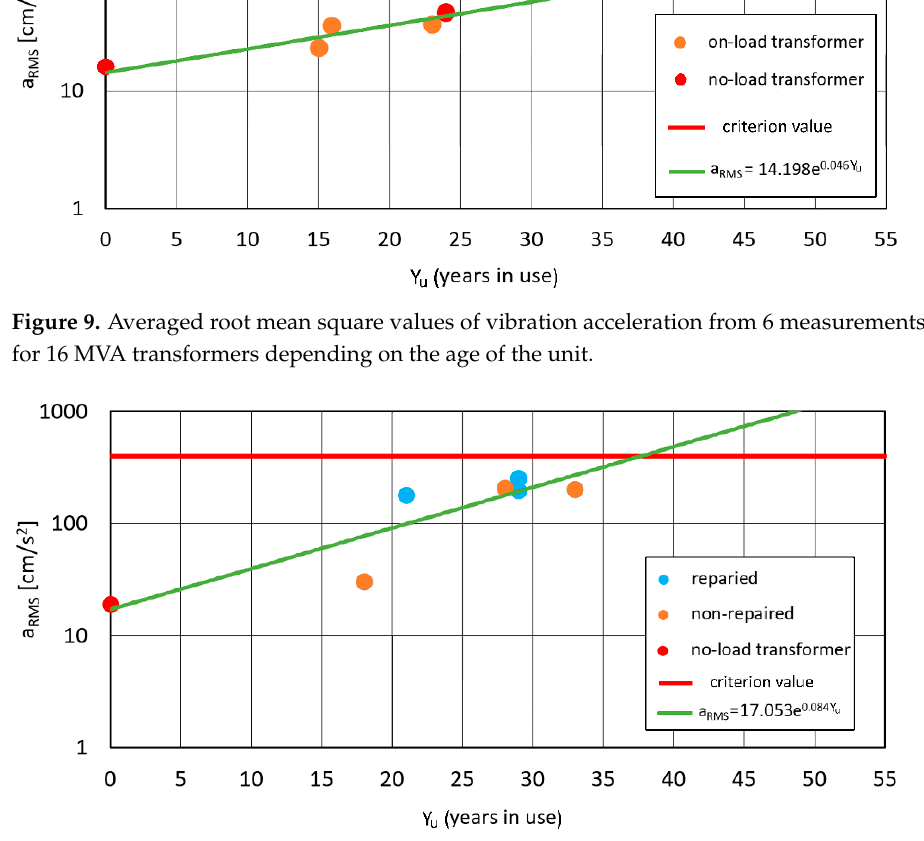
Figure 10. Averaged root mean square values of vibration acceleration from 6 measurements points for 25 MVA transformers depending on the age of the unit.